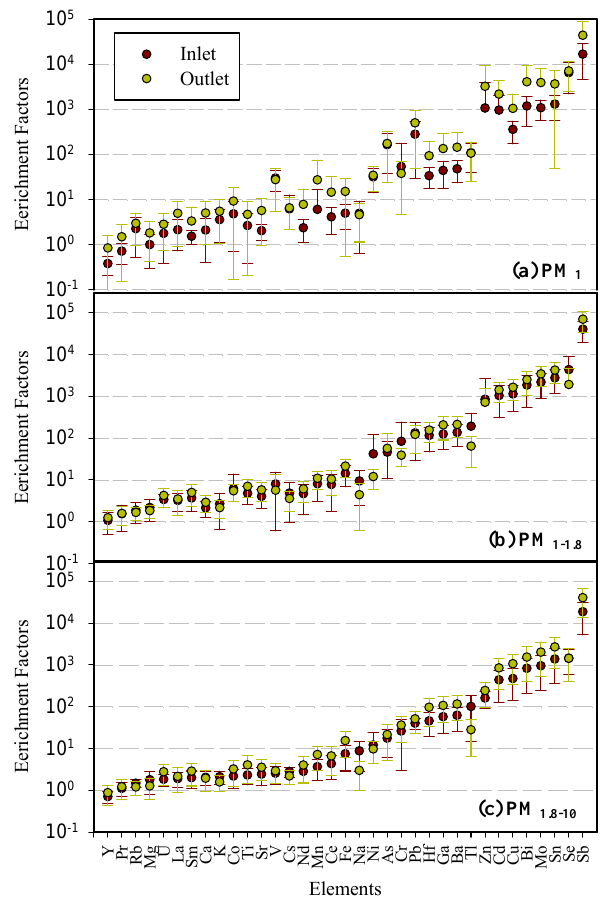
Figure 3. Enrichment factors of trace metals in (a) PM 1 , (b) PM 1–1 . 8 and (c) PM 1 . 8–10 observed at the inlet and outlet sites in Hsuehshan